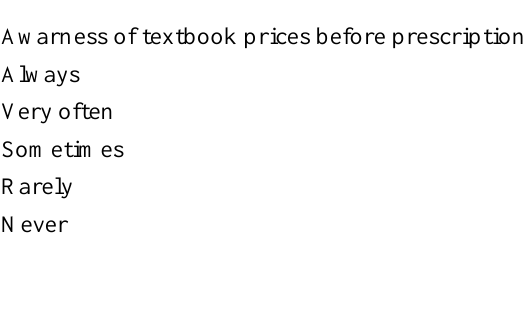
Teachers’ Awareness of Textbook